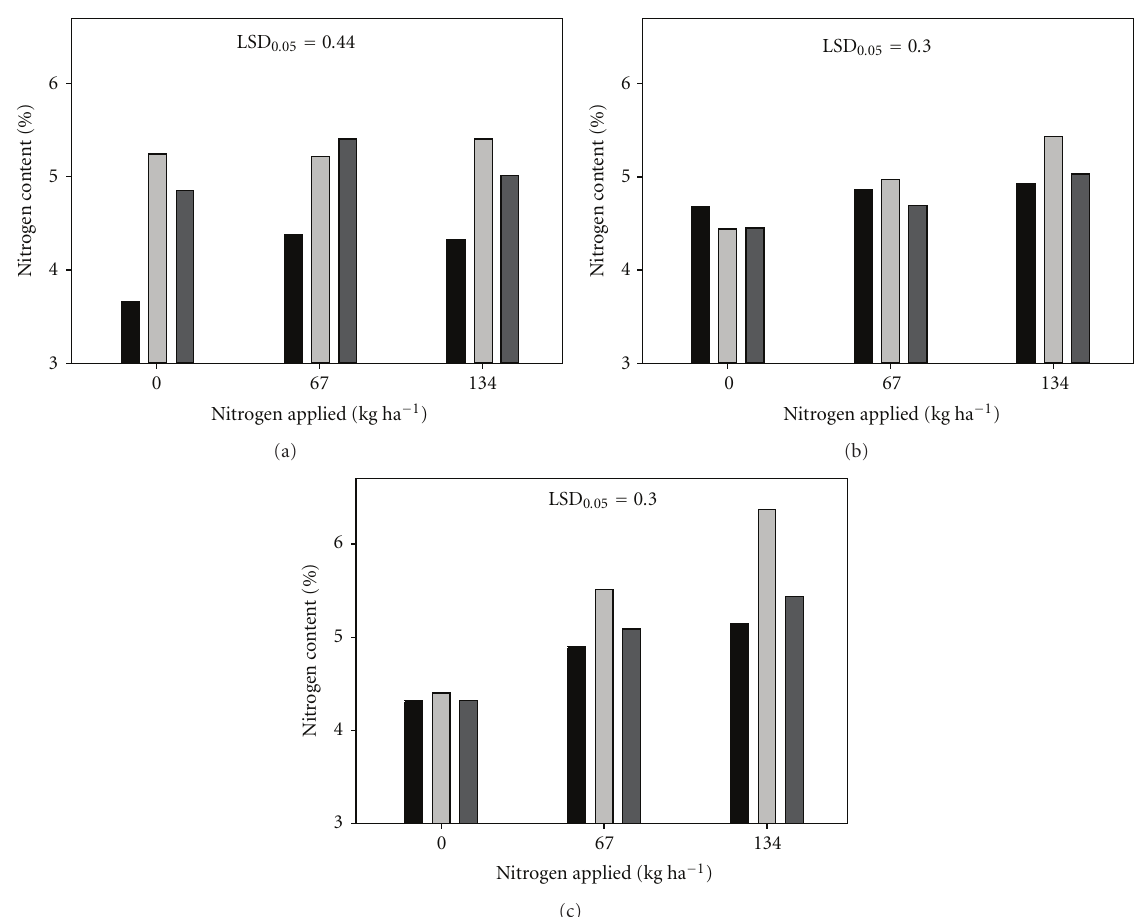
Figure 2: Nitrogen content of cotton leaf at flowering as a ff ected by N rate and cover crop black bars no cover crop, light grey bars Austrian winter pea, dark grey bar hairy vetch, (a) = 2005, (b) = 2006, and (c) = 2007.